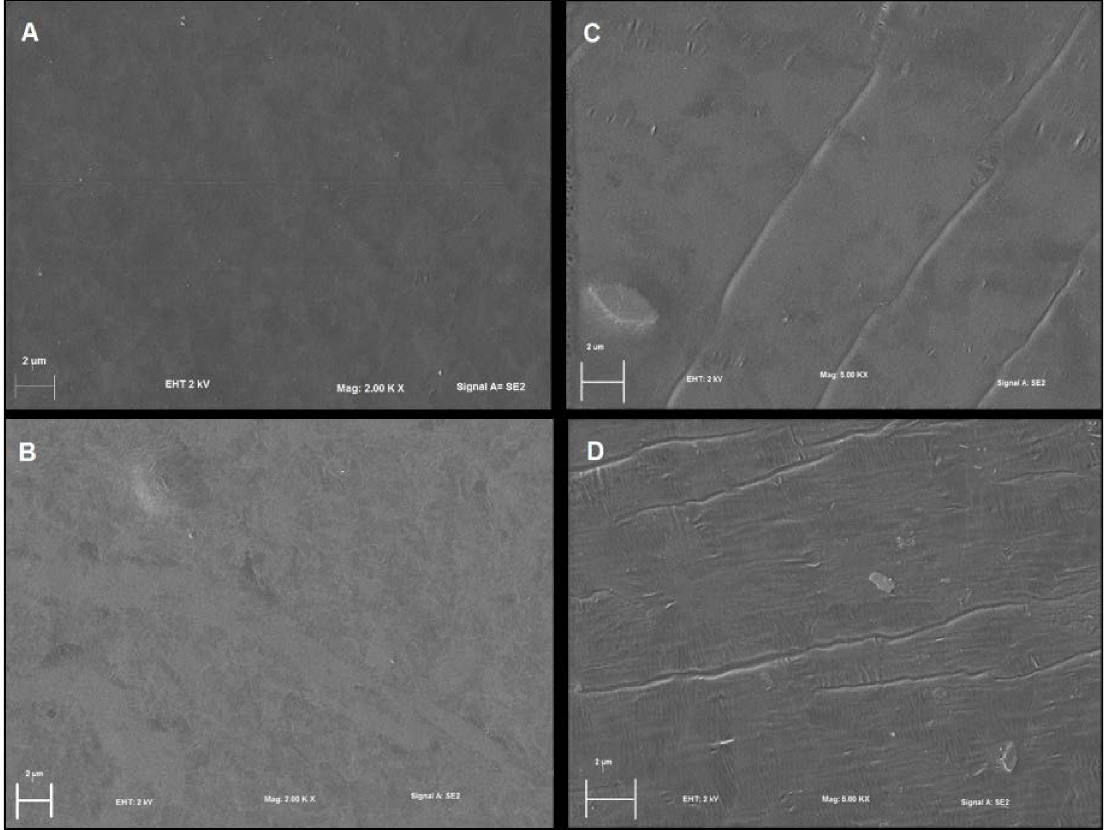
Fig 5. SEM micrograph of gelatin/nisin-EDTA films: A) CF; B) AF1; C) AF2 and D)